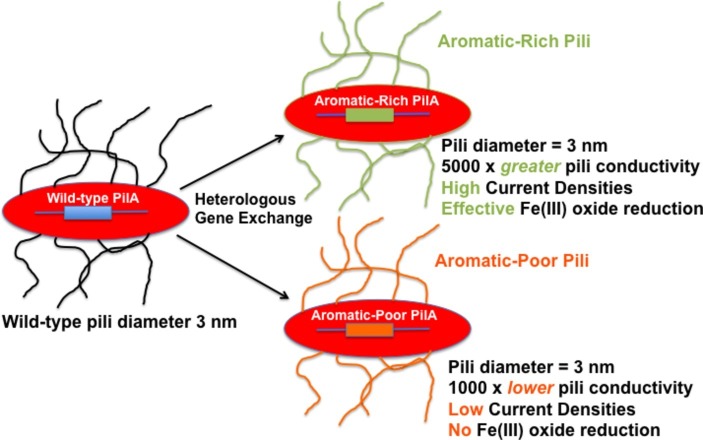
Heterologous expression of PilA pilin monomer genes in G. sulfurreducens yields pili with vastly different (106-fold) conductivities of the individual wires. The pili in the strains with heterologously expressed pilin monomer genes have a diameter that is the same as wild-type pili (3 nm) and inconsistent with the diameter of OmcS filaments (4 nm). Reducing the conductivity of the pili has a dramatic negative impact on phenotypes for extracellular electron transport. The results summarized (Vargas et al., 2013; Tan et al., 2017) are just two examples of many on heterologous expression (Liu et al., 2014; Steidl et al., 2016; Tan et al., 2016b) that have reached similar conclusions.